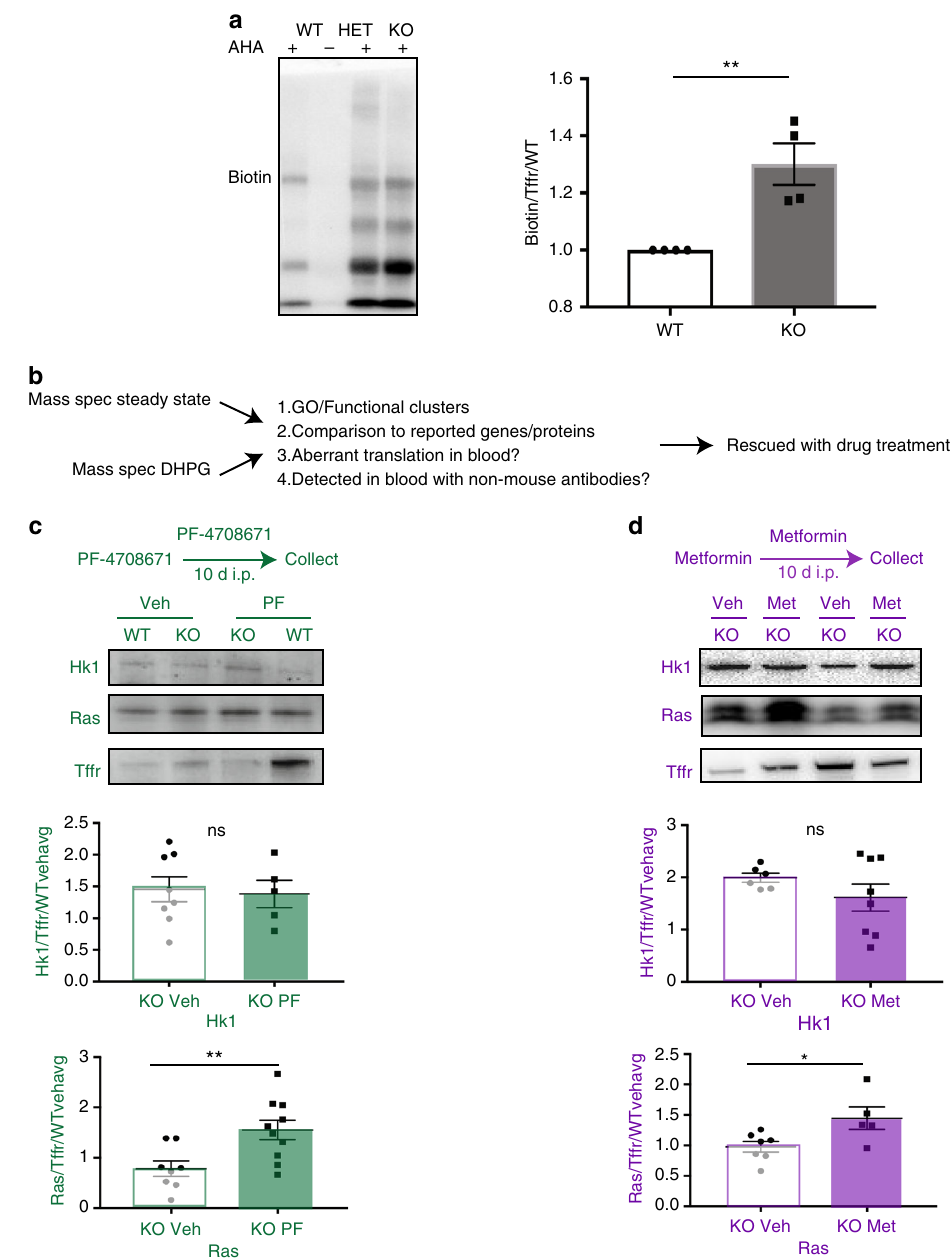
Fig. 4 Whole blood levels of RAS and HK1 are altered in Fmr1 knockout mice in a treatment-dependent manner. a De novo protein synthesis is altered in Fmr1 knockout (KO) mouse whole blood compared to wild-type ( n = 4 WT and n = 4 KO, p < 0.05. b Diagram of how mass spectrometry data (mass spec) were used to compile lists of potential biomarker candidates c ) Schema of PF treatment (top) western blots of Hk1 and Ras normalized to Transferrin receptor (Tffr) (middle) and quanti fi cation (bottom) (Hk1 KO Veh n = 8, Hk1 KO PF n = 5, p = 0.81; Ras KO Veh n = 8, Ras KO PF n = 10, p = 0.008). d Schema of metformin treatment (top) western blots of Hk1 and Ras normalized to Transferrin receptor (Tffr) (middle) and quanti fi cation (bottom). (Hk1 KO Veh n = 6, Hk1 KO Met n = 8, p = 0.24, Ras KO Veh n = 7, KO Met n = 5, p = 0.03) All graphs are represented as mean ± SEM. Statistical analyses using Student ’ s t -test. Outliers were determined a priori as being 2 SD outside of the mean or if the signal to noise ratio was too low on the western blots. Whole blood has high background because of the presence of IgGs and therefore some blots had higher background than brain resulting in the need for higher cohort size to ensure the minimum number of fi nal data